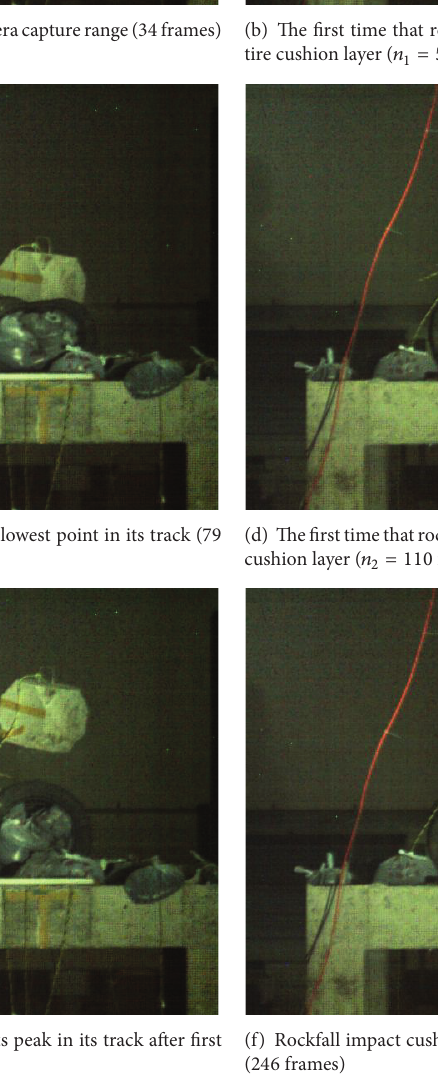
Figure 6: The rockfall impact tack captured by camera in test